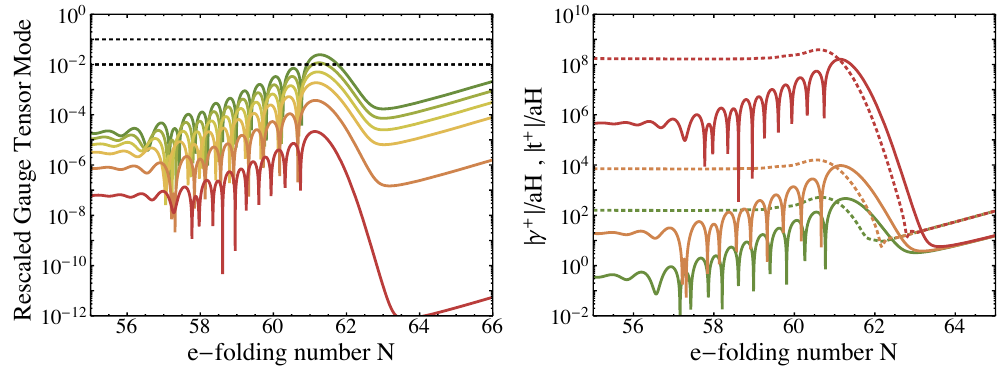
Figure 13 . Left: the rescaled amplitude of the gauge tensor mode given in eq. (4.4) . The horizontal black-dotted lines correspond to 0 : 1 and 0 : 01, which indicate the level of the non-linearity. The parameters used follow the black dots of (cid:12)gure 11, as does the color-coding of the curves. Right: the gauge (solid) and metric (dotted) tensor modes, using the same color-coding. The gauge modes are multiplied by 0 : 1, in order to make the gauge and metric amplitude easier to compare visually. We show only three out of the six curves for